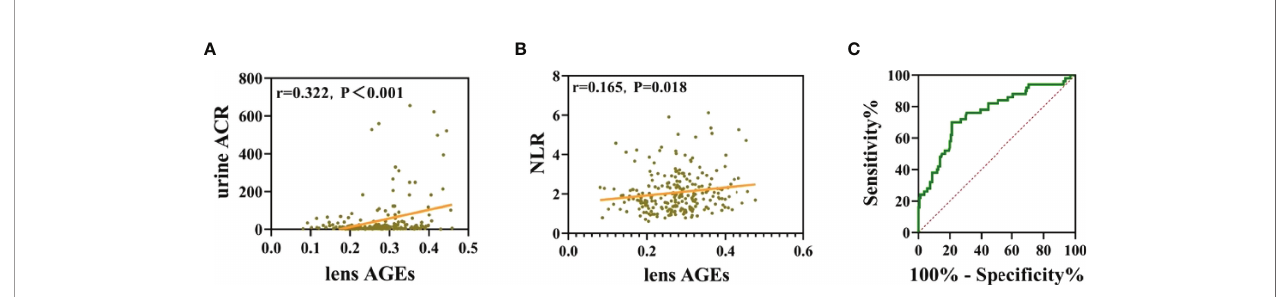
FIGURE 6 | Noninvasive lens AGE measurement has good clinical application value for predicting DKD risk in patients with T2DM. (A) Lens AGE levels were positively correlated with urinary ACR (n = 256). (B) Lens AGE levels were positively correlated with NLR (n = 256). (C) ROC curve analysis showed that lens AGE levels were an independent risk factor